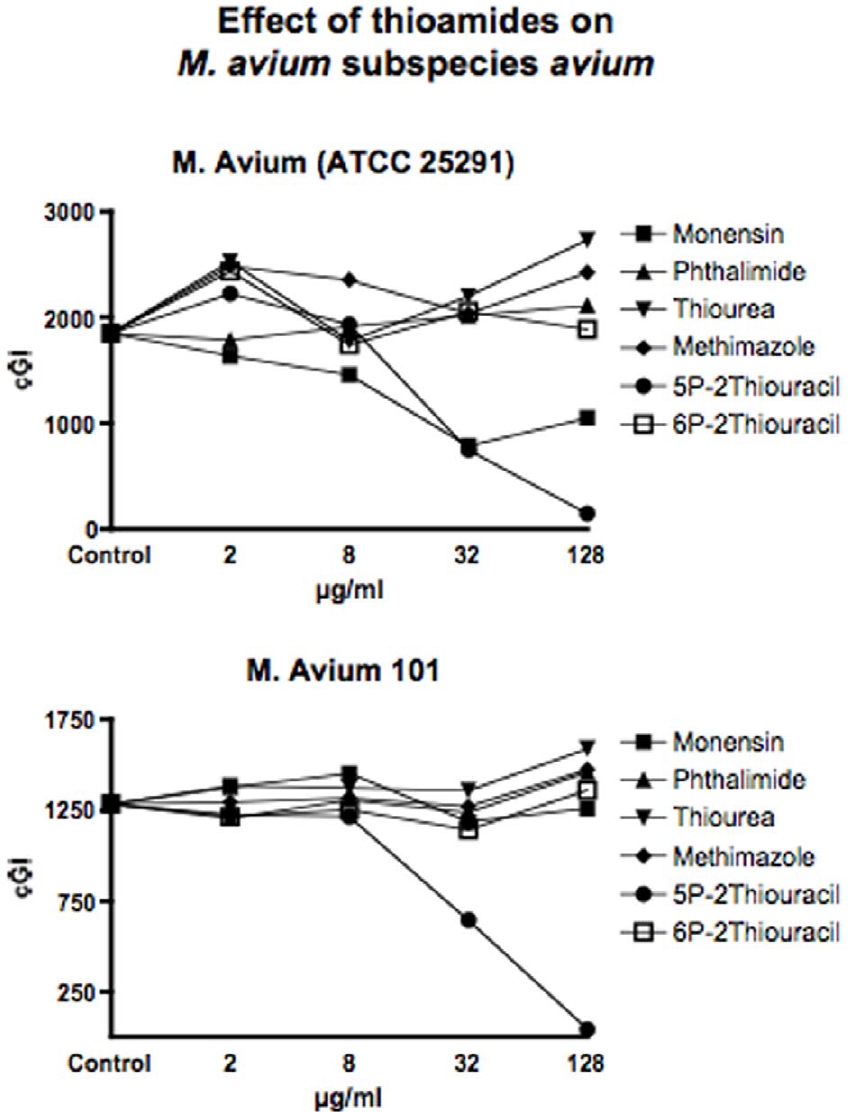
Figure 3. Shown are the cumulative Growth Indices (cGI) for the two M.avium strains. The positive control is Monensin, and the negative control is Phthalimide. Note that 5-PTU is consistently the most effective agent. Monensin does not inhibit M. avium 101, replicating previous findings. [24]